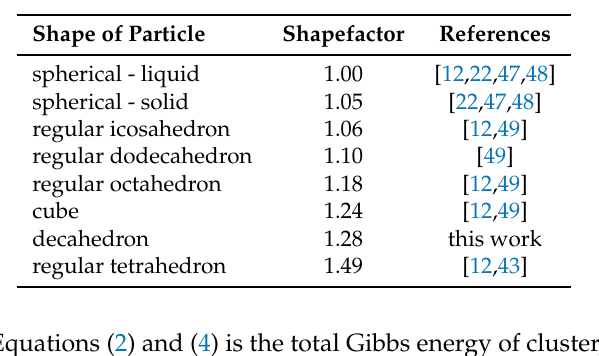
Table 1. Shape factors for different shapes of (nano-)particles as collected from selected literature sources. By a liquid spherical shape we mean an ideal sphere (without any atomic structure manifesting itself) while solid spherical shape represents a spherical nanoparticle with its atomic structure which is making its surface not ideally